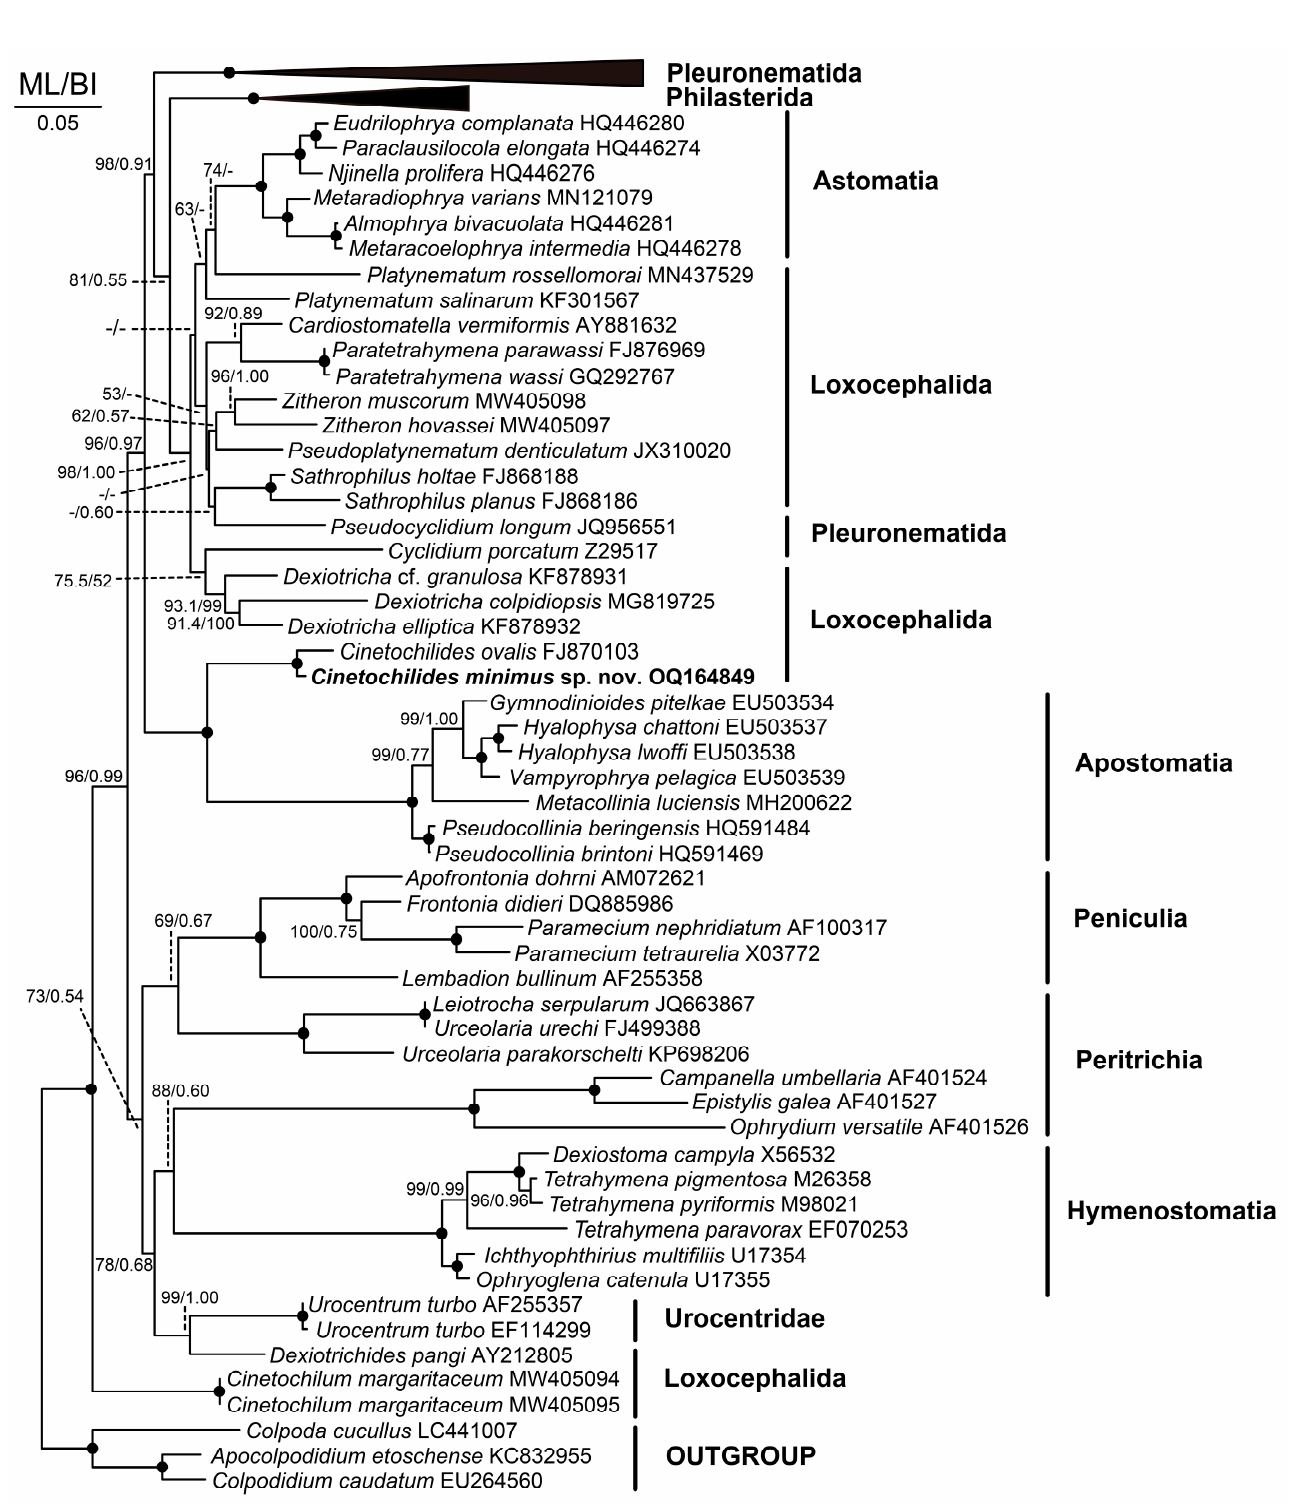
Figure 9. Maximum likelihood (ML) tree based on the 18S rRNA gene sequences showing the phylogenetic relationships of Cinetochilides minimus sp. nov. The new species is denoted in bold. GenBank accession numbers follow the species names. Numbers at the nodes denote the ML bootstrap values and the posterior probabilities of Bayesian inference (BI), while dots at nodes represent 100 bootstrap values and a 1.00 posterior probabilities. Dashes indicate that the supporting values were less than <50% for ML, <0.5 for BI, or the topologies inferred from BI and ML analyses were incongruent. The scale bar represents five nucleotide substitutions per 100 nucleotides.